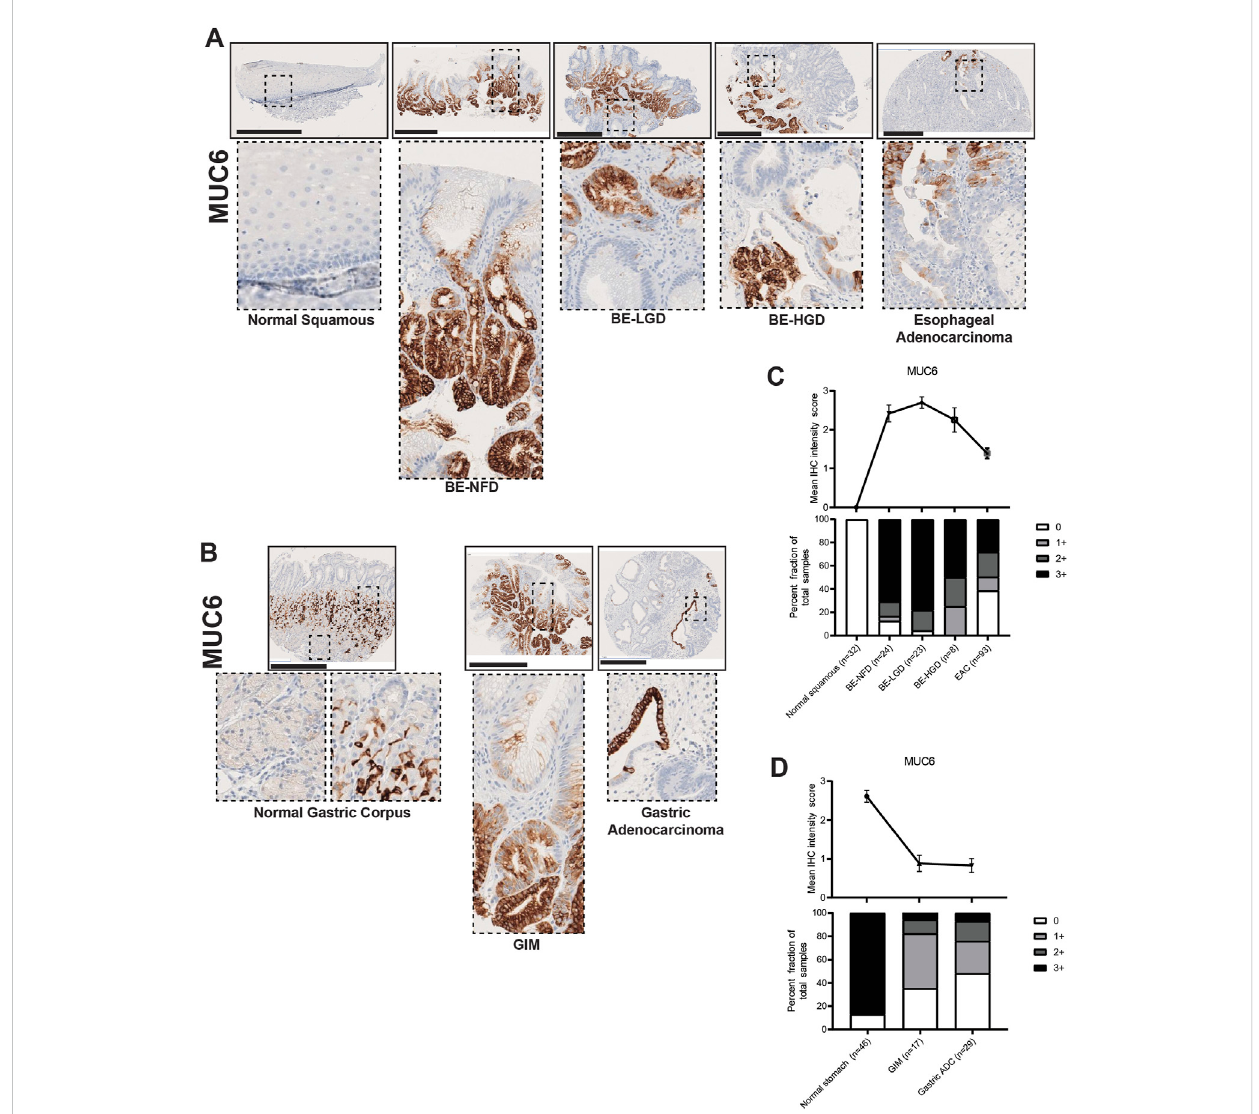
FIGURE 6 MUC6 expression in normal squamous-BE-EAC and normal gastric gland-GIM-GA progression sequence. (A) Immunohistochemistry of MUC6 staining in human tissue microarray esophageal cases, in the same sequence as in Figure 2A. (B) Immunohistochemistry of MUC6 staining in human tissue microarray gastric cases, in the same sequence as in Figure 2B. All scale bars, 500 μ m. (C) Top: the MUC6 average IHC intensity score of eachesophagealphenotypeisplottedinthesamesequenceas inFigure2C.Bottom:theMUC6fractionofesophagealtissuecoreswitheachscore is plotted in the same sequence as in Figure 2C. Each phenotype ’ s total tissue core number is provided at the bottom of each column. (D) Top: the MUC6 average IHC intensity score of each esophageal phenotype is plotted in the same sequence as in Figure 2D. Bottom: the MUC6 fraction of esophageal tissue cores with each score is plotted in the same sequence as in Figure 2D. Each phenotype ’ s total tissue core number is provided at the bottom of each